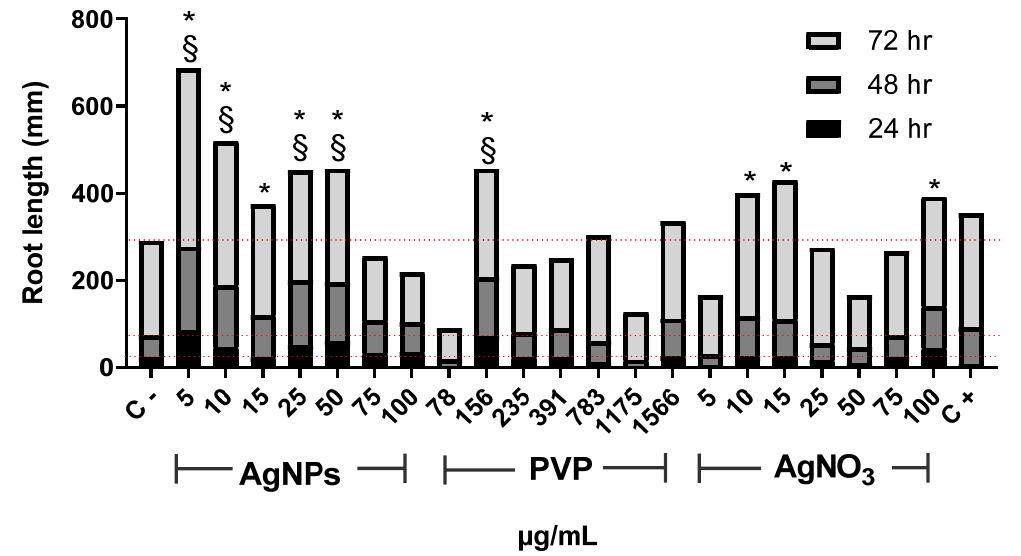
Figure 1. Root elongation of Allium cepa exposed to AgNPs, PVP, and AgNO 3 with di ff erent concentrations after 24 (black), 48 (dark gray), and 72 h (gray) of exposure. The negative control (C − ) was distilled water, and 0.37 µ g / mL of sodium arsenite was used as a positive control (C + ). Dotted lines were included for comparative purposes that show the elongation observed for negative control on each evaluated time. * Indicates significative di ff erences with the negative control ( p < 0.05); § indicates significative di ff erences with the positive control ( p < 0.05) after 72 h of exposure.